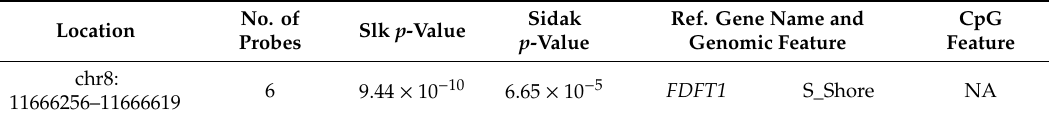
Table 3. Statistically significant di ff erentially methylated regions (DMRs) (Sidak p -value < 0.05) for breastfeeding duration > 3 months.